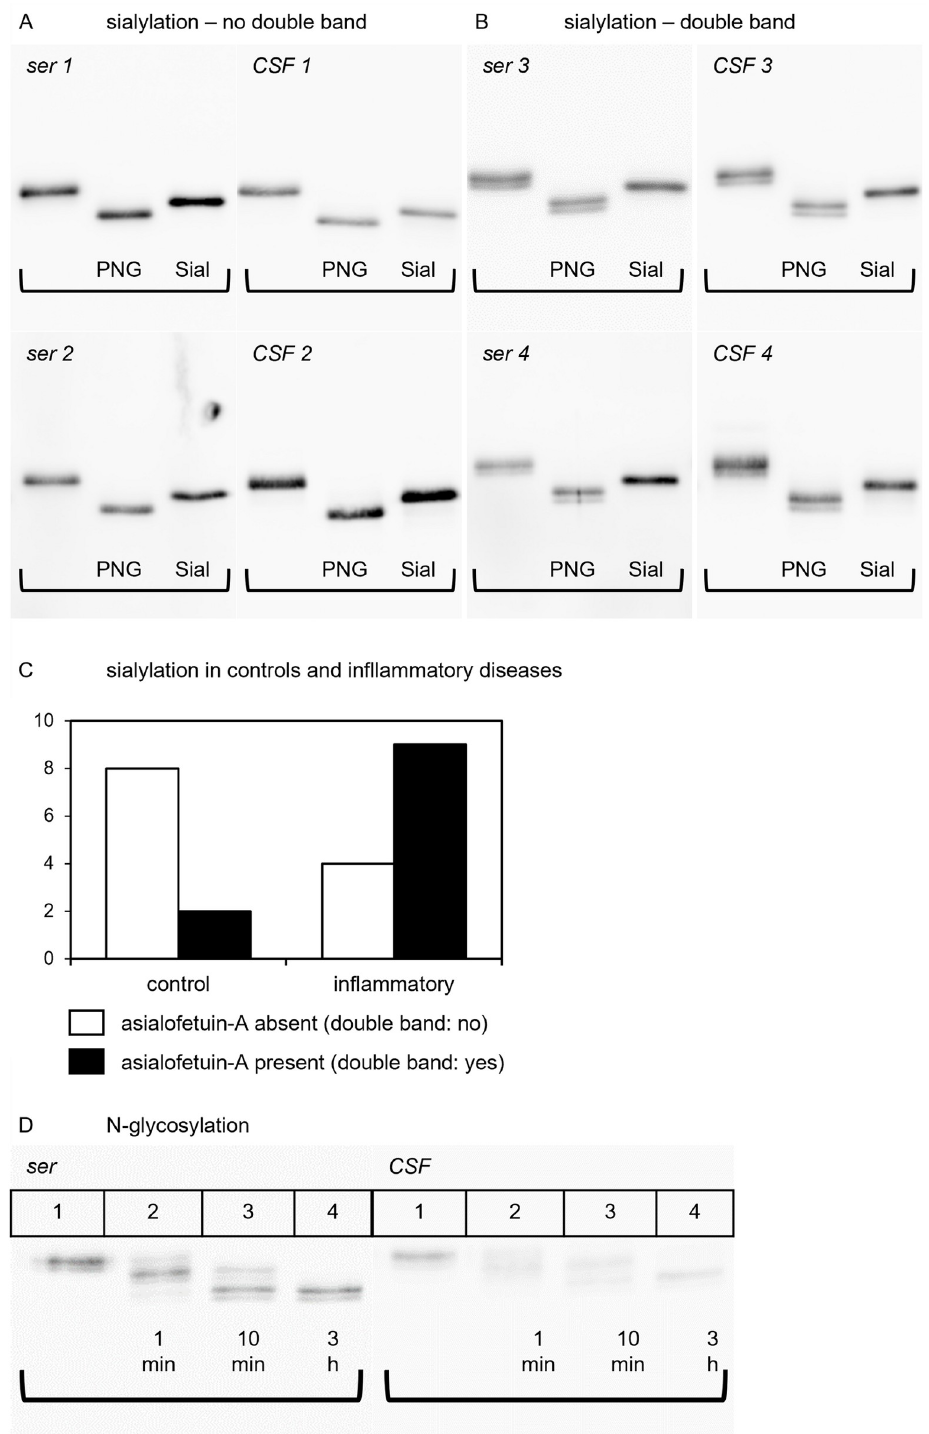
Fig 2. Glycosylation patterns of fetuin-A in CSF and serum. Fig 2 illustrates the results of the glycosylation studies of fetuin-A. (A) and (B) show the glycosylation patterns of fetuin-A with (A) and without (B) double bands. On each membrane, lane 1 shows undigested fetuin-A, lane 2 shows fetuin-A after PNGase-F digestion and lane 3 shows fetuin- A after sialidase-Au digestion. (C) compares the occurrence of double bands in the control group and inflammatory group as a bar chart. (D) displays the kinetic of PNGase-F digestion in serum and CSF. Lane 1 shows